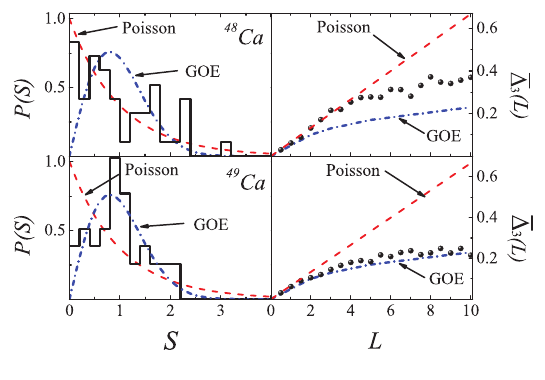
Figure 1. Theoretical values connected by solid lines and the corresponding experimental values (circles) deduced from Ref. [9] for the pairing gap P (in units of MeV) of 42 − 52 Ca as a func- tion of the mass number A .